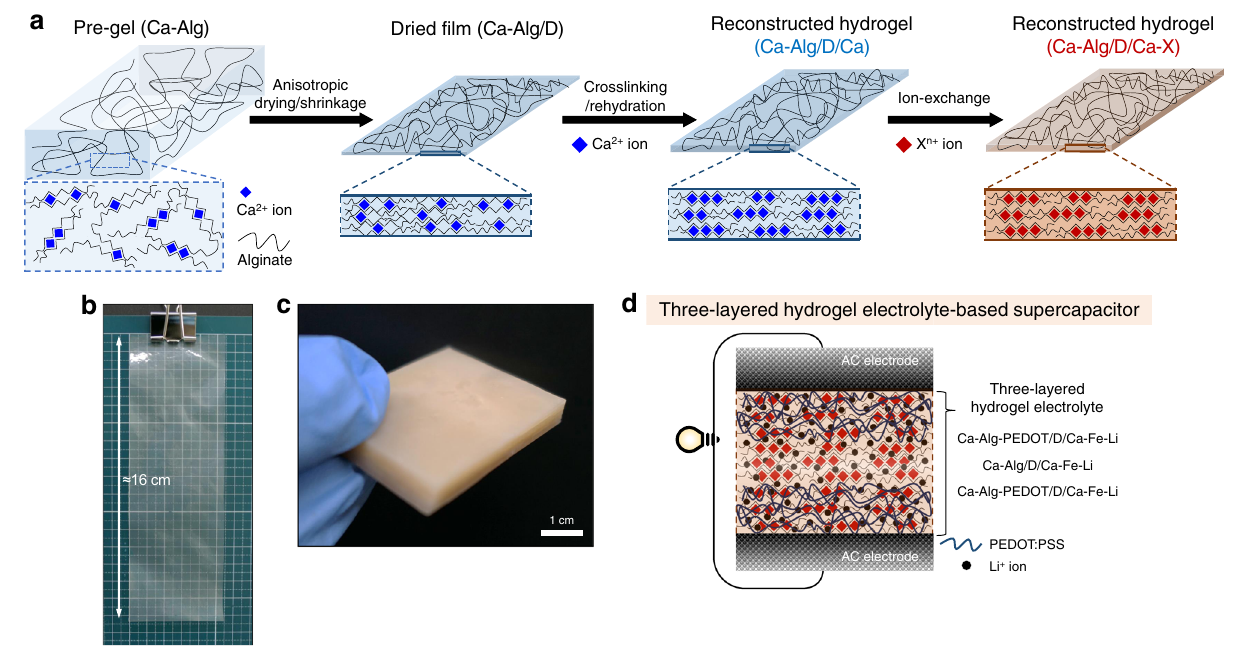
Fig. 1 Schematics of fabrication for reconstructed Alg hydrogel and mechanically robust aqueous supercapacitor. a Fabrication steps of the reconstruction method: anisotropic drying/shrinkage of Ca – Alg pre-gel and crosslinking/rehydration in Ca 2 + solution. To futher enhance the hydrogel mechanical performance, an ion-exchange step from Ca 2 + to X n + (Ba 2 + , Al 3 + , or Fe 3 + ) is additionally introduced. b , c Photographs showing a reconstructed hydrogel with a large area and a thick bulky hydrogel by lamination, respectively. d Schematic illustration of a mechanically robust aqueous supercapacitor composed of activated carbon (AC) electrodes and three-layered hydrogel